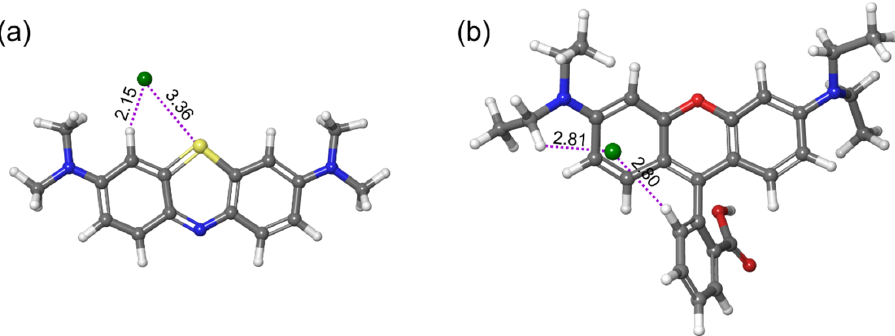
Figure 13. Optimized structures of ( a ) MB and ( b ) RB with distances (in Å) between anion and